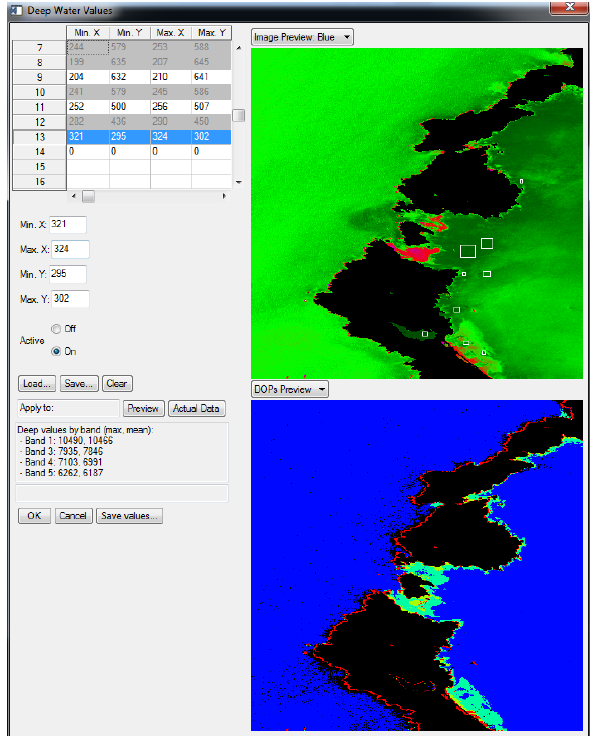
Figure 4. Various deep water sample areas, and the DOP zones resulting from using one of them.